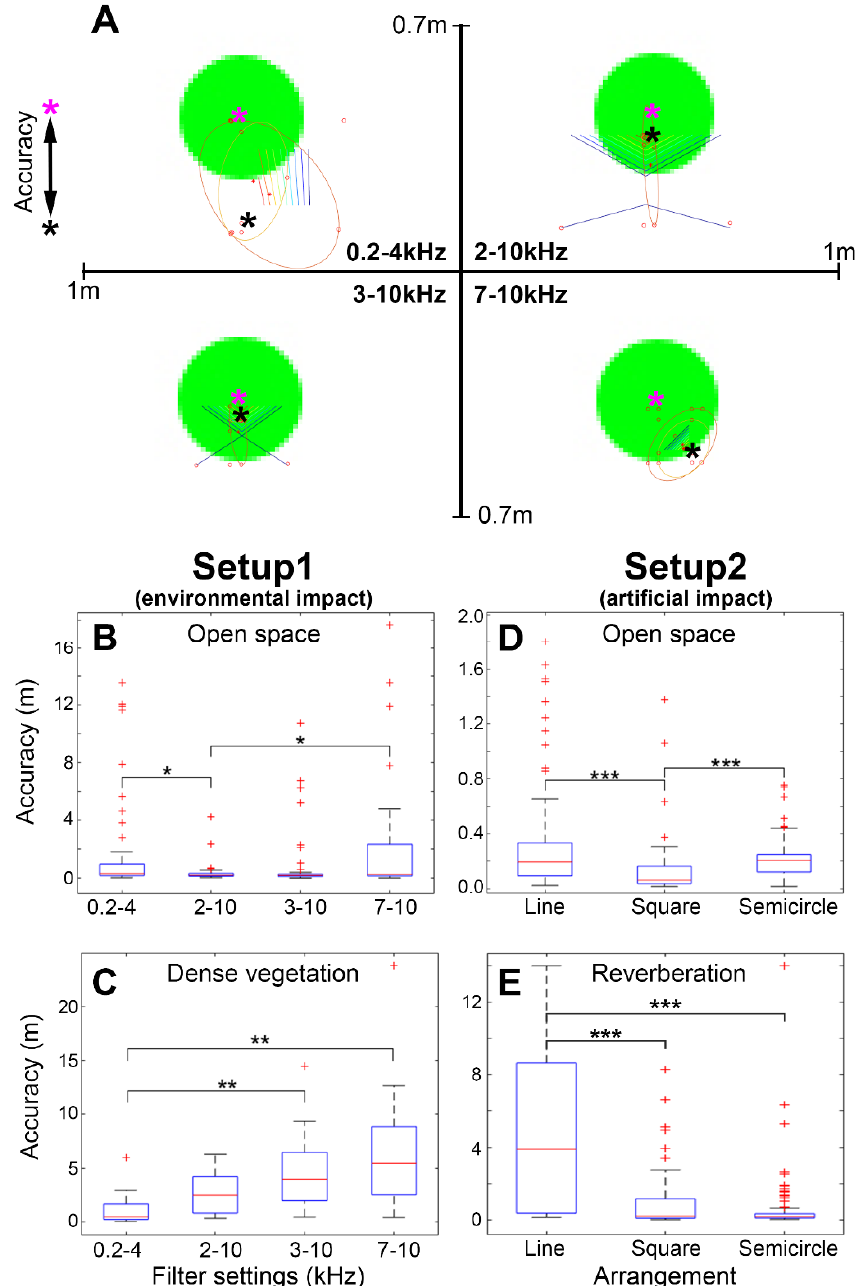
Figure 4. ( A ) Exemplary result of a sound localization. The distance between the actual position of the sound source (pink asterisk) and the position estimated via the software Localize Animal Sound Events Reliably (LASER) (black asterisk) is used to determine the accuracy. In this example, the accuracy for sound localization using a filter setting of 0.2–4 kHz is 0.284 m, the accuracy using a filter setting of 2–10 kHz is 0.069 m, the accuracy using a filter setting of 3–10 kHz is 0.049 m, and the accuracy using a filter setting of 7–10 kHz is 0.177 m. ( B – E ) Statistical results presented as boxplots. ( B ) Comparison of the influence of the used frequency range on the accuracy of sound localization in open space. ( C ) Comparison of the influence of the used frequency range on the accuracy of sound localization in dense vegetation. ( D ) Comparison of the influence of the arrangement of the microphones on the accuracy of sound localization in open space. Low-cut filter was set to 2–10 kHz. ( E ) Comparison of the influence of the arrangement of the microphones on the accuracy of sound localization in a reverberant environment. Low-cut filter was set to 2–10 kHz. Only significant differences are shown: (*) p ≤ 0.05; (**) p ≤ 0.01; (***) p ≤ 0.001.